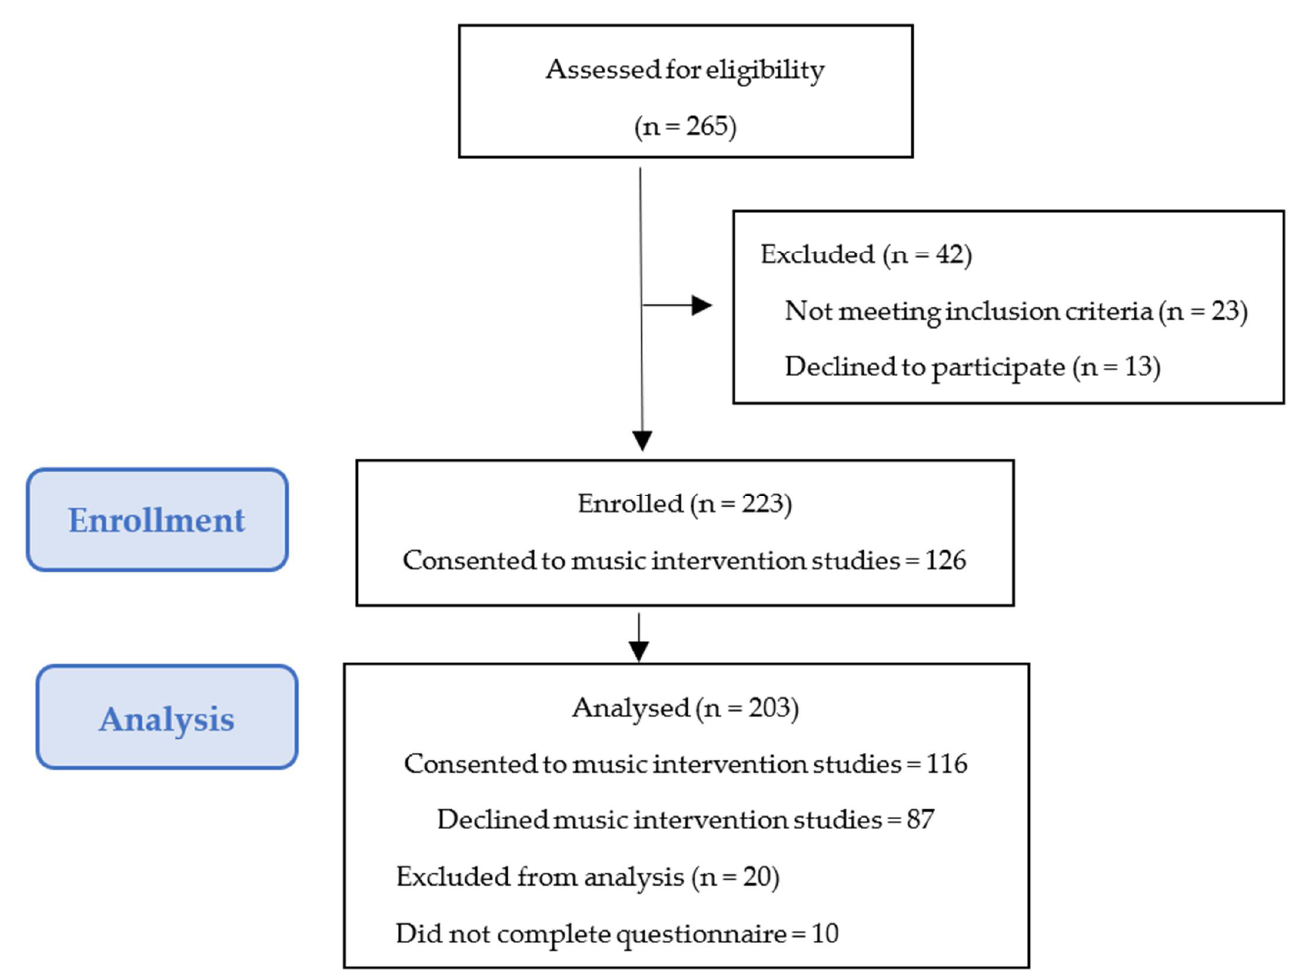
Figure 2. Study flow diagram.